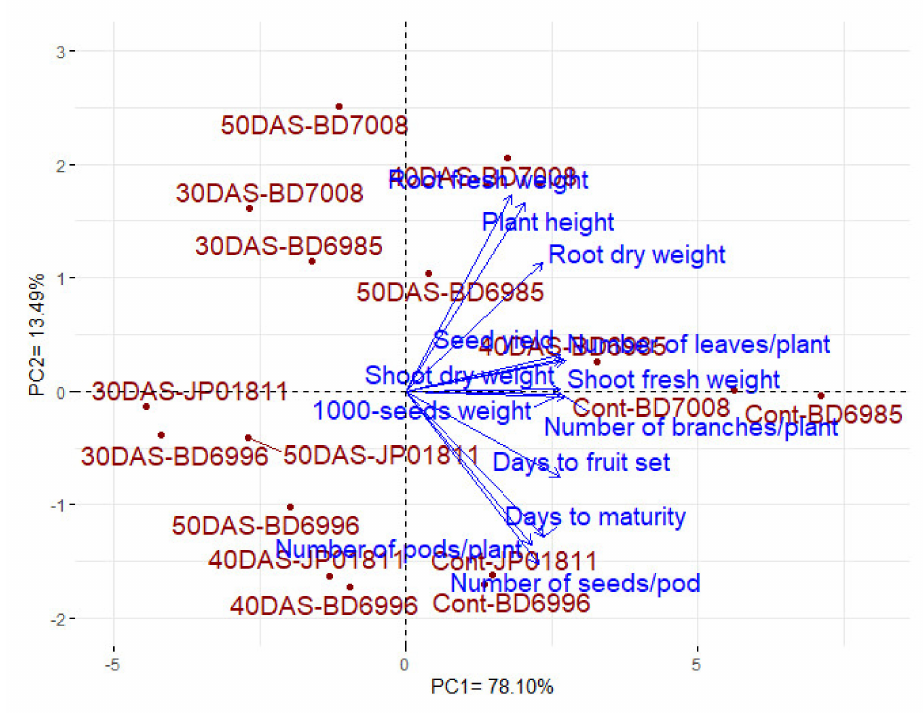
Figure 5. PCA biplot for the evaluated traits of four sesame genotypes (BD-7008, BD-6985, BD-6996, and JP-01811) under four waterlogging treatments—control, 30, 40, and 50 days after sowing, which are presented as Cont, 30D, 40D, and